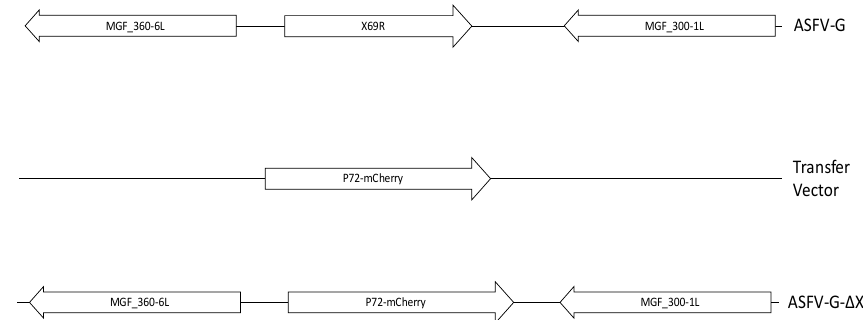
Figure 3. Schematic for the development of ASFV-G- Δ X69R. The transfer vector contains p72 promoter and the mCherry cassette, along with the flanking left and right arms of the transfer vector, designed to have flanking ends to both sides of the deletion/insertion cassette. The resulting ASFV-G- Δ X69R virus with the cassette inserted is shown on the bottom; the insert cassette is a direct replacement for the ORF X69R.